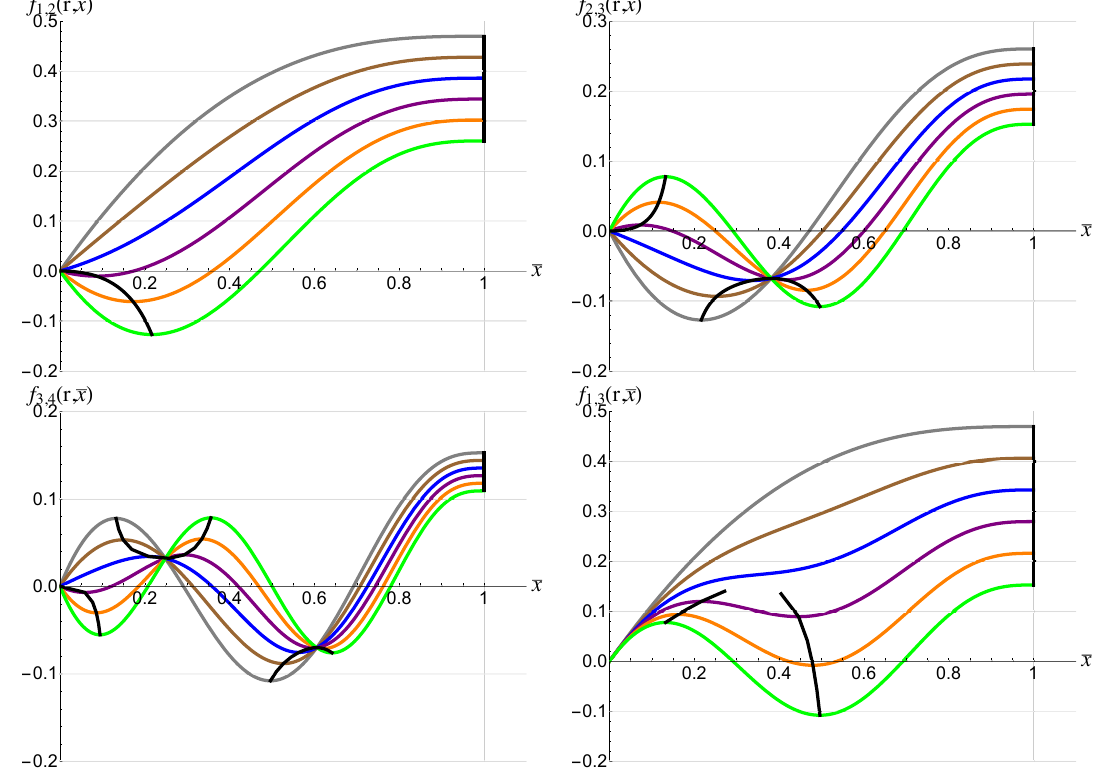
Figure 3. The functions f i for different combinations of the first four eigenmodes. grey: r = 0.0; 1 , i 2 brown: r = 0.2; blue: r = 0.4; purple: r = 0.6; orange: r = 0.8; green: r = 1.0; black: extrema line